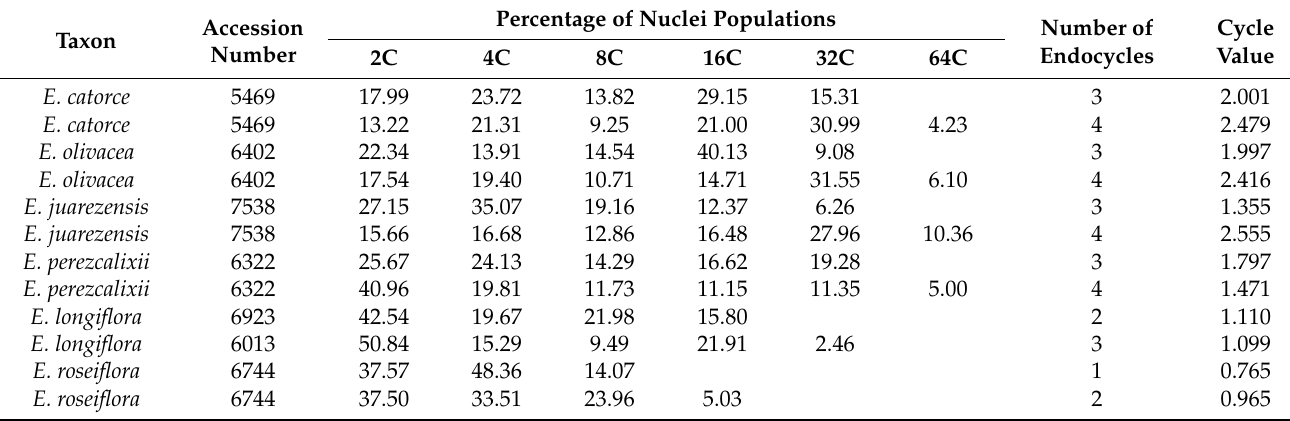
Table 5. Distribution of the percentage of endopolyploidy nuclei, number of endocycles, and cycle value in 6 Echeveria species that present 2 endopolyploidy levels among individuals of the same